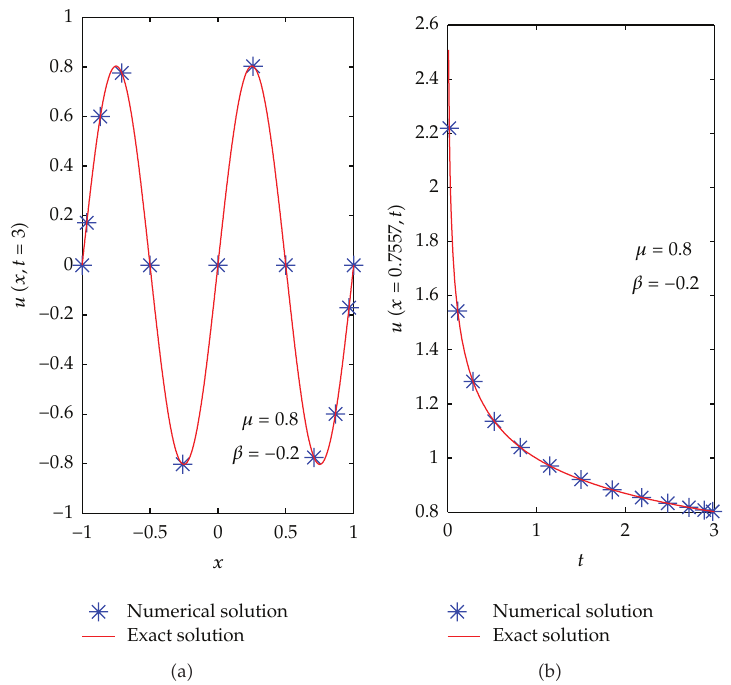
Figure 4: (cid:4) a (cid:5) The comparison of the exact solution and numerical solution when t (cid:6) 3. (cid:4) b (cid:5) The compare of the exact solution and numerical solution when x (cid:6) 0 .